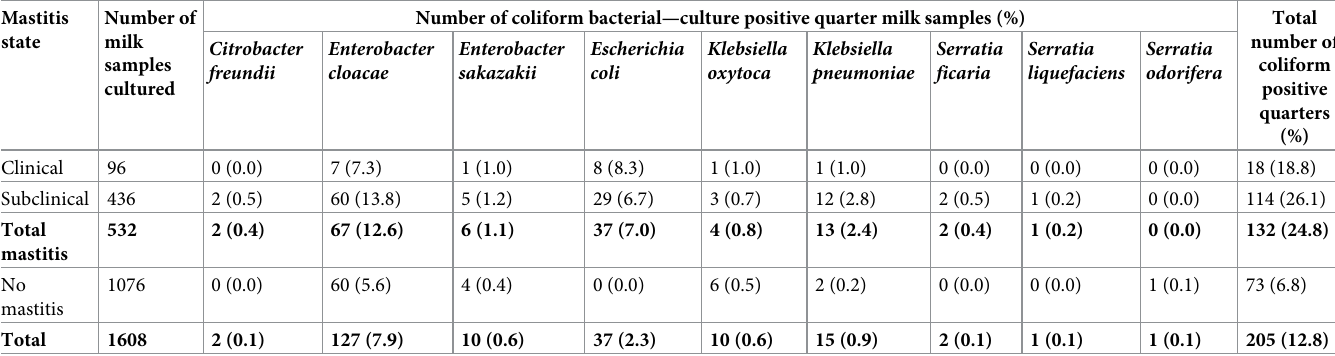
Table 4. Occurrence of coliform bacterial isolates in quarter milk samples.